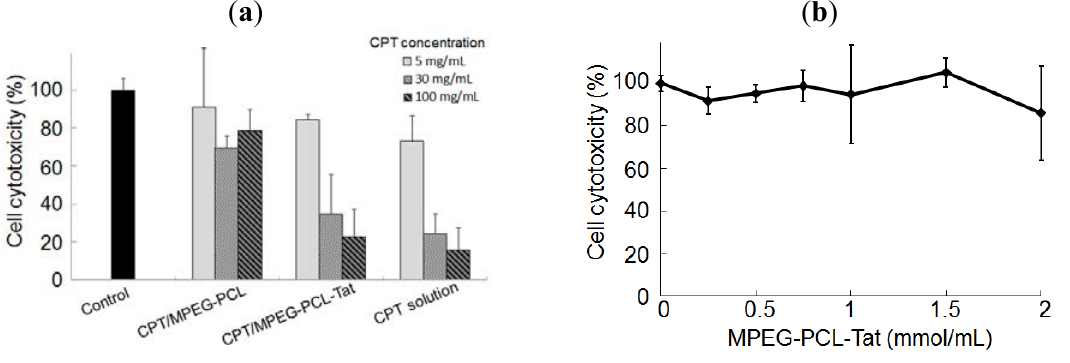
Figure 1. In vitro cytotoxicity in C6 cells transfected with camptothecin (CPT). ( a ) Cell cytotoxicity (%) in C6 cells 12 h after transfection with untreatment (control; black) and 5 (light gray), 30 (medium gray) and 100 (dark gray hatch) mg/mL of CPT solution, CPT-loaded MPEG-PCL and CPT-loaded MPEG-PCL-Tat. Each bar represents the mean ± S.D. (n = 3). ( b ) Cell viability (%) in C6 cells 12 h after transfection with various concentrations of CPT-free MPEG-PCL-Tat. Each bar represents the mean ± S.D. (n = 3).